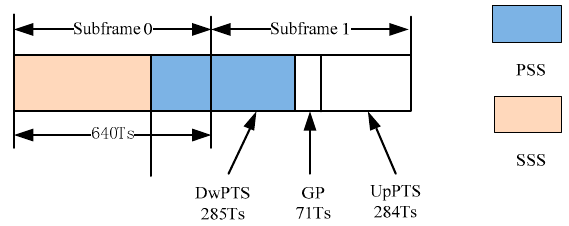
Figure 8. Illustration of the PSS and SSS in an LTE 230 subframe.